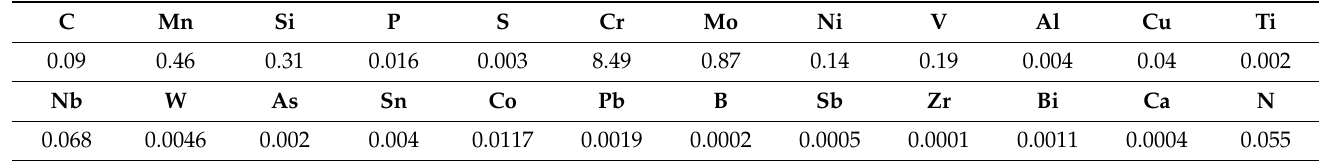
Table 1. Chemical analysis (%) of the P91 tube